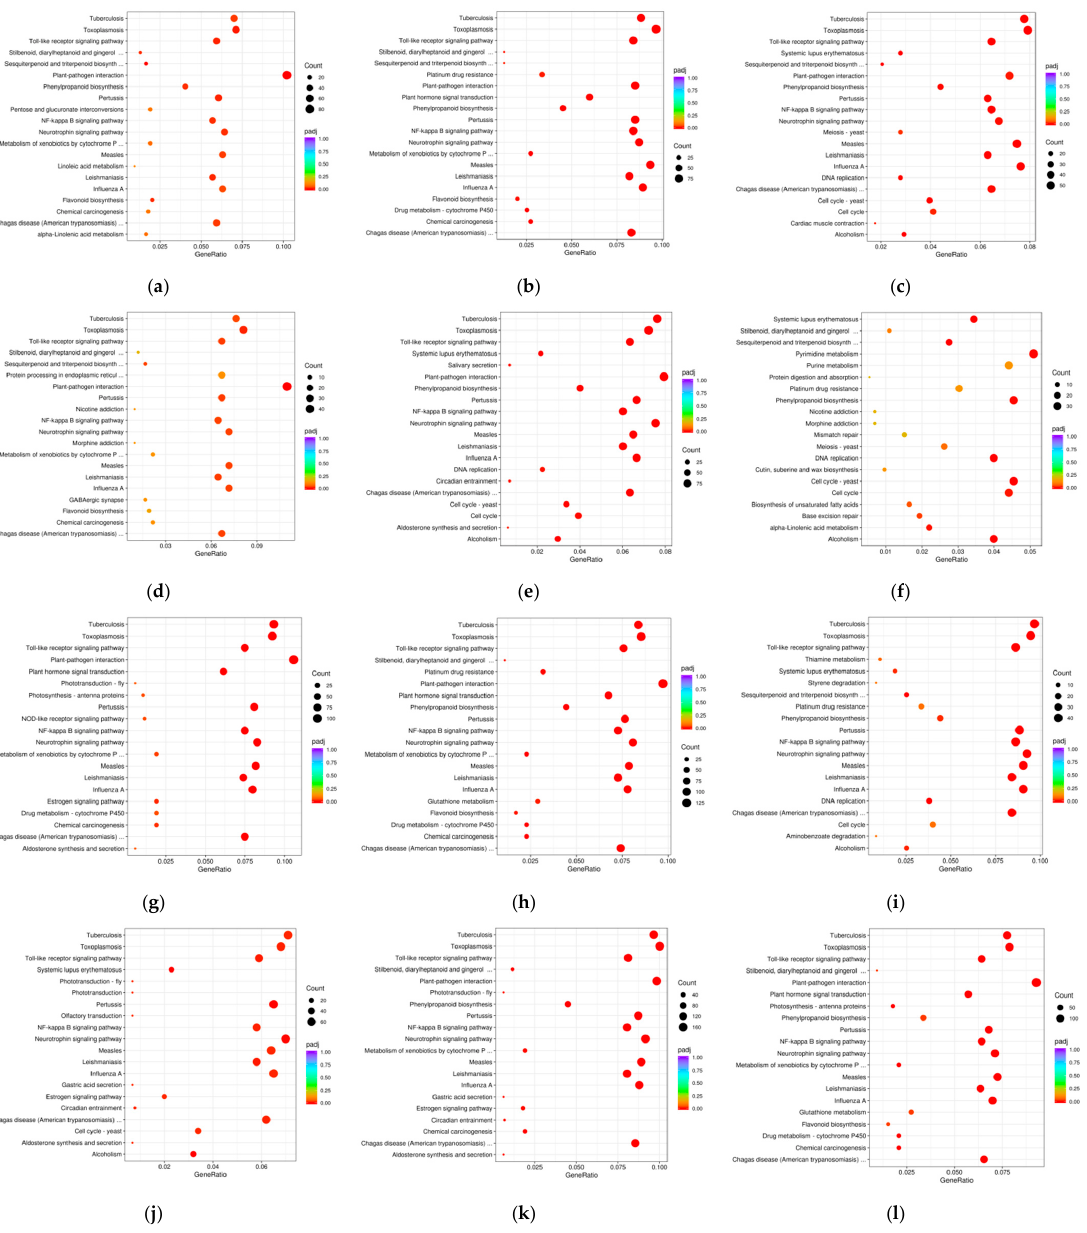
Figure 6. KEGG enrichment scattered plots analysis between pairwise comparison samples. ( a ) ‘TRI-2025 ′ vs. ‘Tambi-2 ′ ; ( b ) ‘Tambi-2 ′ × ‘Suka Ati-40 ′ vs. ‘Tambi-2 ′ ; ( c ) ‘Tambi-2 ′ × ‘Cinyiruan-143 ′ vs. ‘Tambi-2 ′ ; ( d ) ‘Tambi-2 ′ × ‘TRI-2025 ′ vs. ‘Tambi-2 ′ ; ( e ) ‘Kiara-8 ′ × ‘Sukoi’ vs. ‘Tambi-2 ′ ; ( f ) ‘Tam- bi-1 ′ × ‘Kiara-8 ′ vs. ‘Tambi-2 ′ ; ( g ) ‘Tambi-2 ′ × ‘TRI-2025 ′ vs. ‘Tambi-2 ′ × ‘Suka Ati-40 ′ ; ( h ) ‘Tambi-2 ′ × ‘Cinyiruan-143 ′ vs. ‘Tambi-2 ′ × ‘Suka Ati-40 ′ ; ( i ) ‘Tambi-2 ′ × ‘TRI-2025 ′ vs. ‘Tambi-2 ′ × ‘Cinyiru- an-143 ′ ; ( j ) ‘Tambi-2 ′ × ‘Suka Ati-40 ′ vs. ‘Kiara-8 ′ × ‘Sukoi’; ( k ) ‘Kiara-8 ′ × ‘Sukoi’ vs. ‘Tambi-2 ′ × ‘TRI-2025 ′ ; ( l ) ‘Kiara-8 ′ × ‘Sukoi’ vs. ‘Tambi-2 ′ × ‘Cinyiruan-143 ′ .